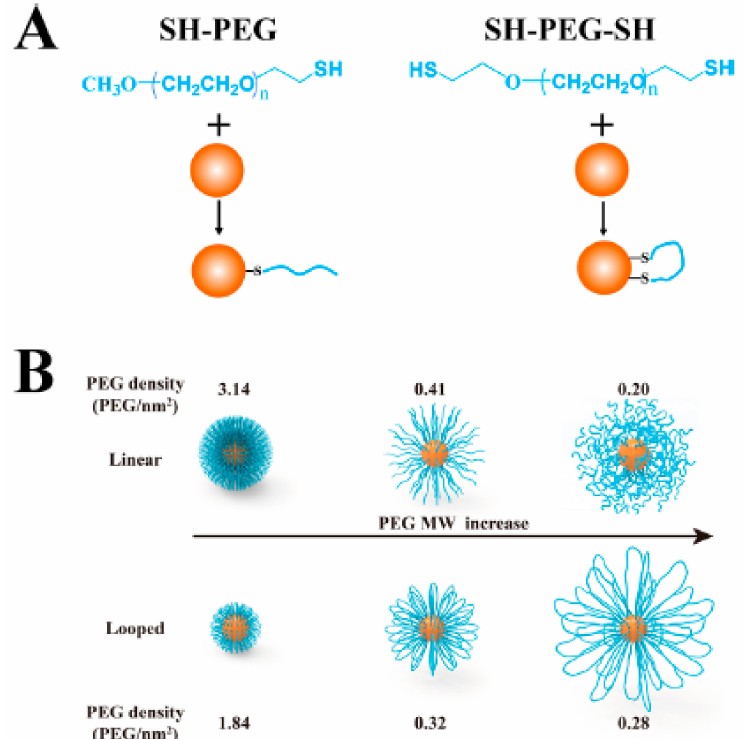
Figure 9. Au nanoparticles carrying linear or loop PEG shells. ( A ) Structure of linear and loop PEG ligands and binding over Au nanoparticle surface. ( B ) Au nanoparticles with linear (top) or loop (bottom) PEGs of di ff erent sizes (1, 5, or 10 kDa; from left to right) representing changes in the graft density and hydrodynamic radii of the di ff erent polymeric shells. Reprinted with permission from reference [52]. Copyright (2019) American Chemical